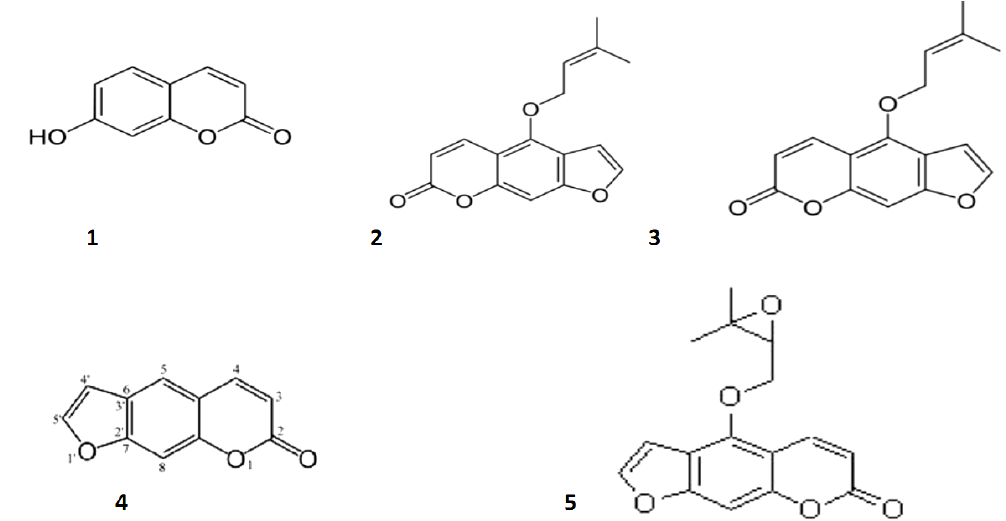
Fig. 1. Molecular s tructures of individual